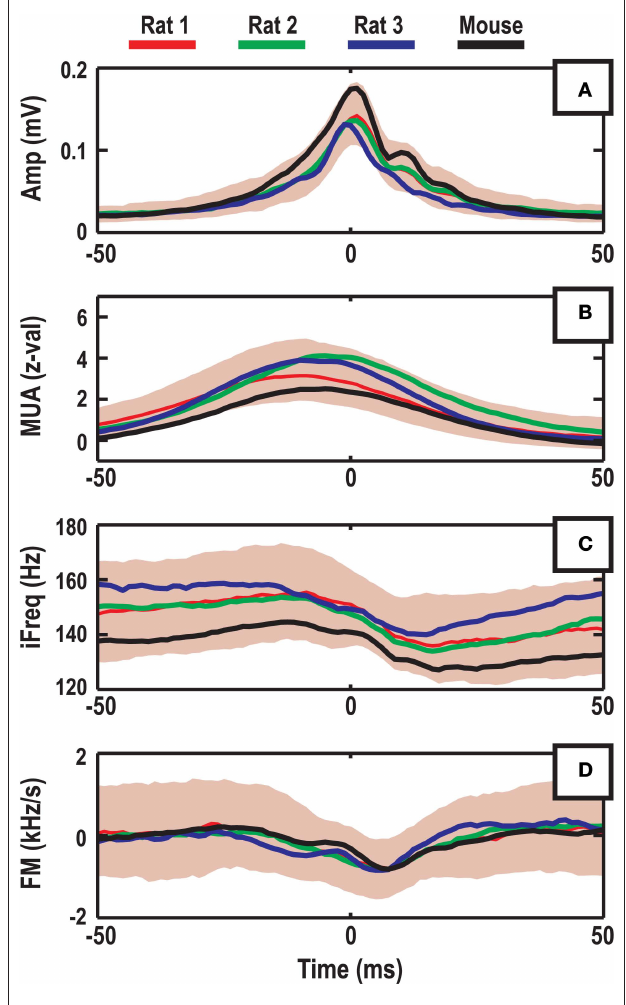
FIGURE 2 | Ripple triggered statistics of (A) amplitude envelope, (B) normalized multi-unit activity, (C) iFreq measure, and (D) FM measure. The red, green, and blue lines are median waveforms of data from three different rat subjects, while the solid black line represents one mouse subject. The solid patch in the background represents the empirical 50% confi dence bound computed with the Rat 1 data